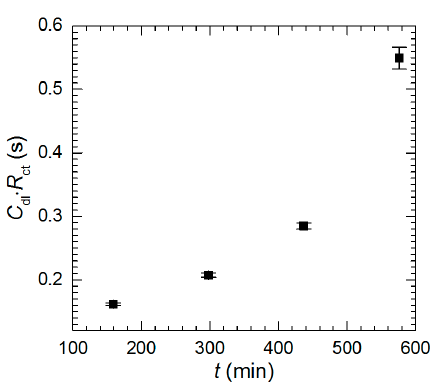
= 1.3, c = 0 mM, T = 303 V